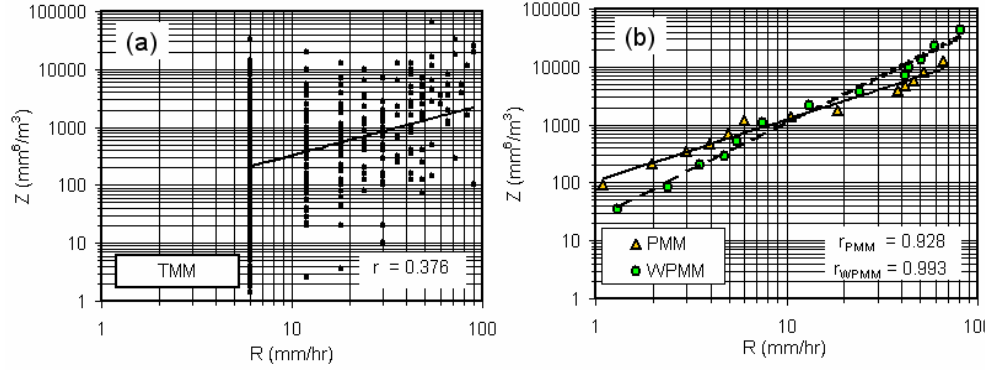
Figure 8. Fig. 8. Scatter plot of Z e − R pairs based on TMM (a) , PMM and WPMM (b) during 15–18 September 1999. Table 6. Cumulative mean areal rainfall (CMAR) and PD CMAR for different WCMM